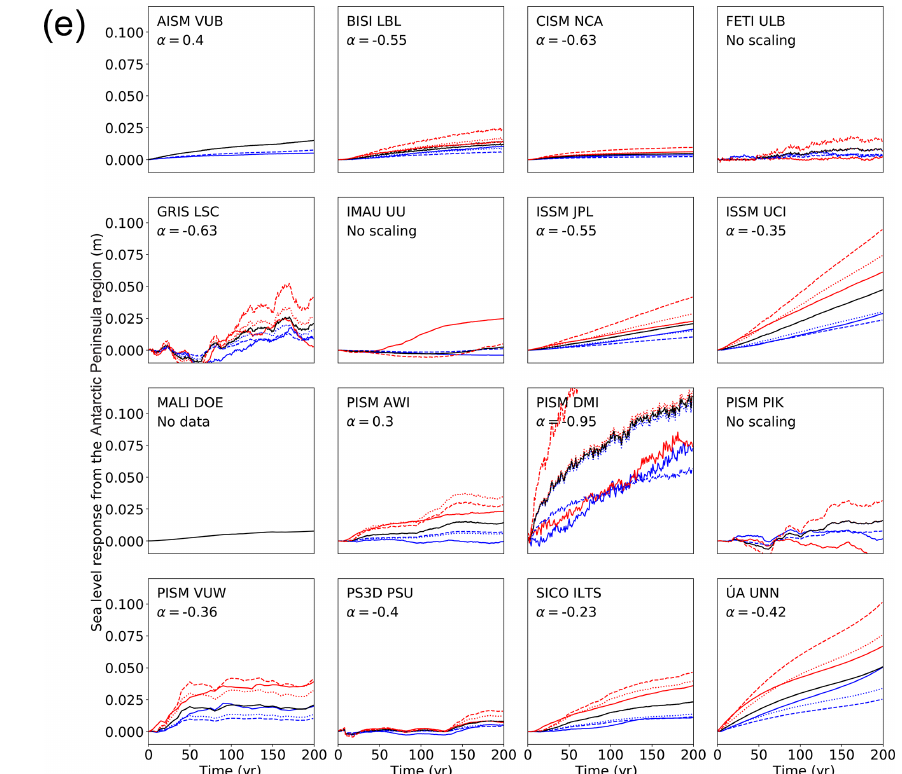
Figure 4. (a) Linearity check for East Antarctica. Response of ice sheet models to additional basal melting of 8myr − 1 (solid black line) underneath all ice shelves in East Antarctica compared to 4myr − 1 (solid blue line) and 16myr − 1 (solid red line). In order to check the linearity of the response to the warming amplitude the dashed red line gives the times series of the response to 8myr − 1 of basal melt multiplied by 2 and the dashed blue line the same but divided by 2. The dotted lines give the scaled response with the scaling exponent α (see Eqs. 5 and 6). A positive scaling exponent means that the ice sheet model responds super-linearly to basal ice shelf melting in this region. A negative α indicates a sub-linear response in this region. AISM VUB did not provide a 16myr − 1 simulation. The black dashed line for BISI LBL represents the simulation with 500m horizontal resolution that is used for the projections. The linearity is tested with a set of simulations at 1km horizontal resolution. (b) Linearity check for the Ross region as in panel (a) . (c) Linearity check for the Amundsen region as in panel (a) . (d) Linearity check for the Weddell region as in panel (a) . (e) Linearity check for the Antarctic Peninsula as in panel (a)